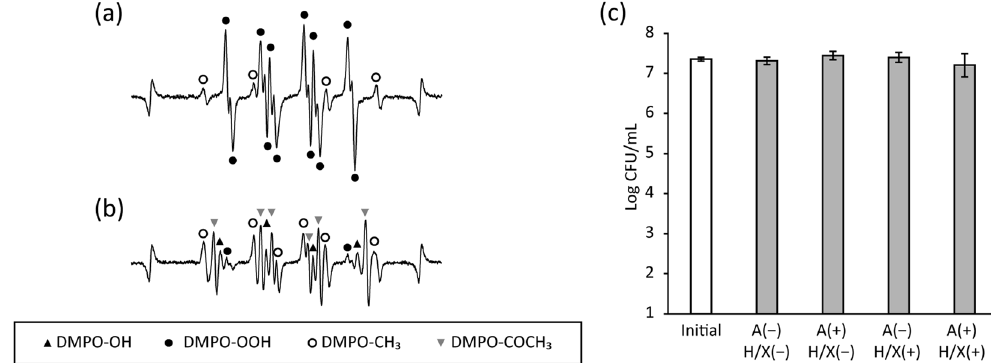
Figure 6. Generation of acetyl radicals by oxidation of acetaldehyde and evaluation of their antimicrobial activity. Superoxide anion radicals and acetyl radicals were qualitatively analysed using electron spin resonance (ESR)-spin trapping technique using 5,5-dimethyl-1-pyrroline N-oxide (DMPO) as a spin trap agent. The number of bacteria was determined after each treatment by standard plate counting. ( a ) Representative ESR spectra of DMPO-OOH (spin adduct of superoxide anion radicals: closed circle) generated by hypoxanthine (50 µ M)/xanthine oxidase (50 mU/mL) reaction system. The peaks at both ends represent Mn 2 + used as an internal standard. ( b ) Representative ESR spectra of DMPO-COCH 3 (spin adduction of acetyl radicals: inverse triangle) generated as a result of oxidation of 50 mM acetaldehyde by superoxide anion radicals. ( c ) Antimicrobial activity of acetyl radicals. Values and error bars in ( c ) indicate the mean and standard deviation, respectively. A: 50 mM acetaldehyde, H/X: 50 µ M hypoxanthine and 50 mU/mL xanthine